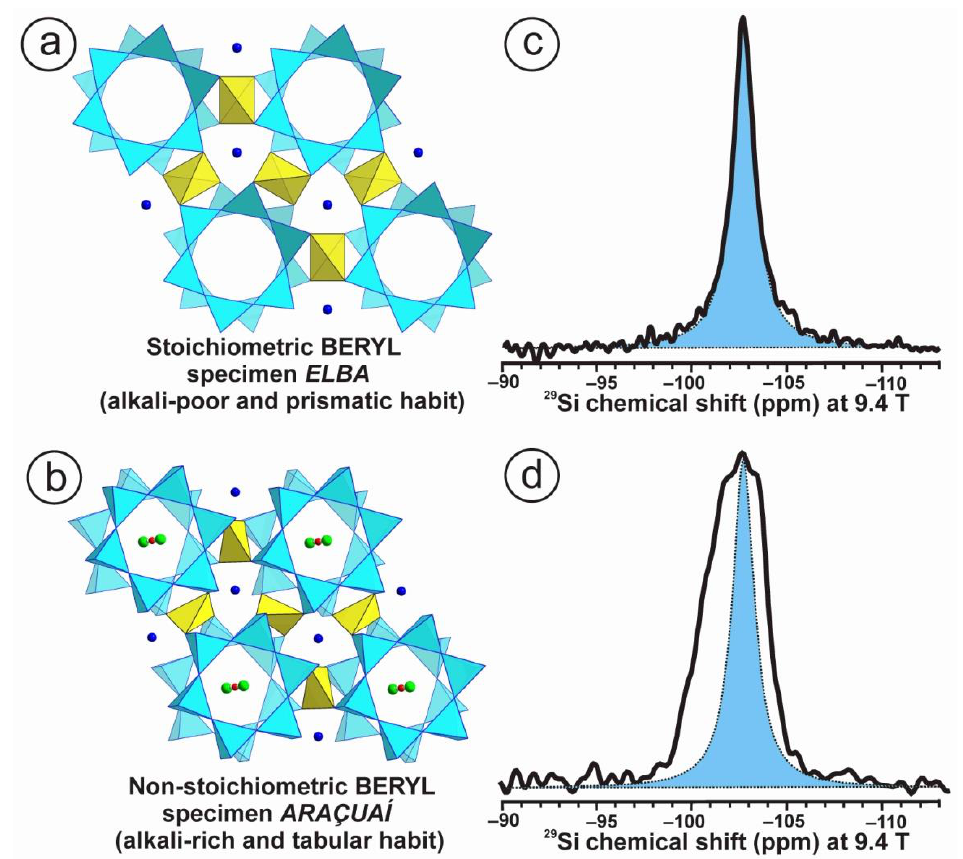
Figure 5. ( a ) P 6 3 / mcc space-group lattice model of the structure of beryl with hexagonal symmetry and a chemical composition close to Be 3 Al 2 Si 6 O 18 projected onto the (001) plane. The Si atoms at tetrahedral sites (blue) form six-membered rings; the Be atoms occupy one tetrahedral site (yellow) connecting two Si rings to give Si in Q 4 (2Si,2Be) environments, and the Al atoms occupy a single octahedral site [47]. ( b ) The same lattice model in an alkali-rich beryl along the same projection but slightly tilted to show Na atoms in green and H 2 O molecules in red for the oxygen atom or Cs atoms [48]. In this case, the Li atoms are at the Be site, and Na and Cs atoms are in channels at the height of Si rings and Be–Al layers, respectively. Oxygen atoms of H 2 O molecules in red are supposed to be located between two Na atoms [49]. In addition, H 2 O molecules are thought to be at the site of Cs atoms. ( c ) The 29 Si MAS NMR spectrum of specimen Elba at 9.4 T shows a single resonance that can be simulated with a Lorentzian curve (in blue) centered at − 102.7 ppm and a line width of 1.4 ppm. ( d ) The 29 Si spectrum of specimen Araçua í at 9.4 T shows a much broad resonance, compared to that of specimen Elba (blue), centered at ca. − 102 ppm and a line width of 3.6 ppm. The experimental conditions for the acquisition of the 29 Si MAS NMR spectra at 9.4 T, at υ r = 10 kHz in a 4 mm rotor, are similar to those used for alkali feldspars